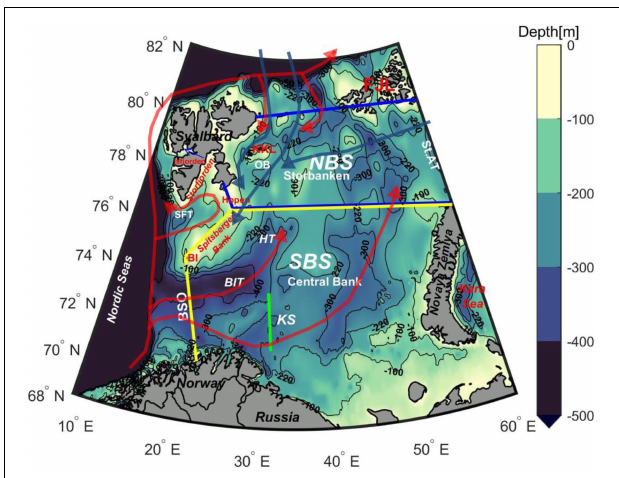
FIGURE 1 | Bathymetric map of the study area with main geographical features. Bathymetric data obtained from a global 30 arc-second interval grid (GEBCO, https://www.gebco.net) with 10 m as the minimum depth. The Barents Sea was divided into two regions: northern Barents Sea (NBS, area inside the solid blue line), and southern Barents Sea (SBS, area inside the solid yellow lines). Red arrows show Atlantic water currents, blue arrows show Arctic water currents. Isobaths of 100, 220, 300, and 500 m are shown in black. The abbreviations stand for the Barents Sea Opening (BSO), Bear Island Trough (BIT), Hopen Trench (HT), Bear Island (BI), Storfjorden Trough (SFT), Kong Karls Land (KKL), Olga Basin (OB), Franz Joseph Land (FJL), and the St. Anna Trough (St.AT). The Kola Section (KS) is marked with straight green line.